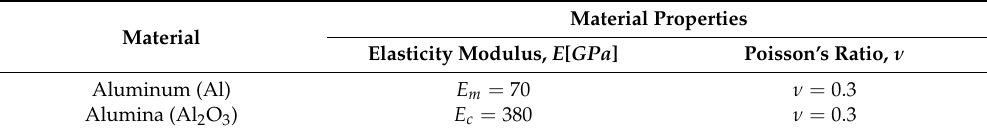
Table 2. Material properties of FGM